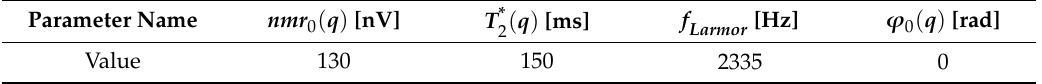
Table 2. Parameters setting of the ideal MRS signal.